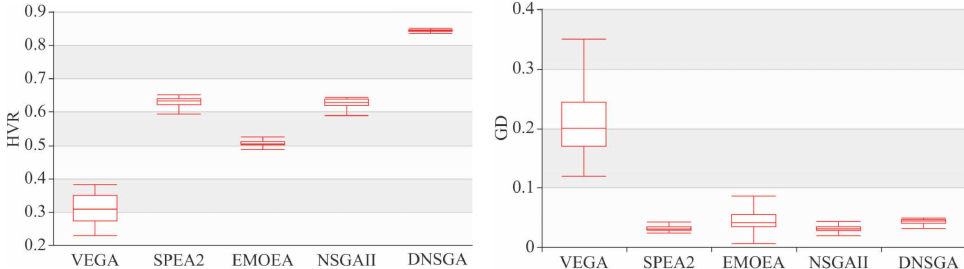
Figure 2. Performance comparison of different multi-objective evolutionary algorithms on the test function ZDT2.